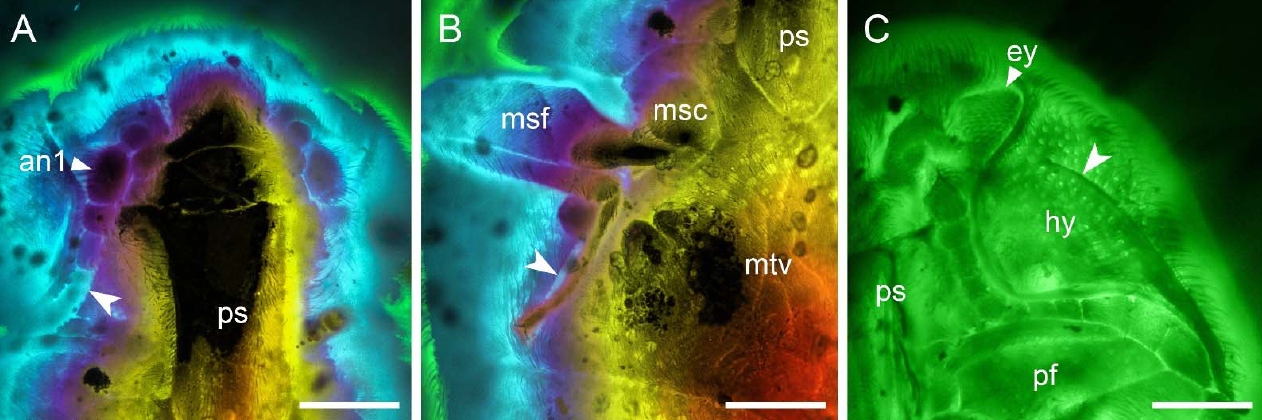
Figure 10. Details of Pseudopactopus robustus gen. et sp. nov. , under confocal microscopy. ( A , B ) Holotype, NIGP173917, with depth colour coding. ( A ) Head and prothorax, ventral view, showing the prothoracic antennal groove (arrowhead). ( B ) Middle leg and metaventrite, ventral view, showing the mesotarsal groove (arrowhead). ( C ) Paratype, NIGP173918, head and prothorax, ventral view, showing the incomplete lateral pronotal carinae (arrowhead). Abbreviations: an1, antennomere 1; ey, compound eye; hy, hypomeron; msc, mesocoxa; msf, mesofemur; mtv, metaventrite; pf, profemur; ps, prosternum. Scale bars: 200 μ m.